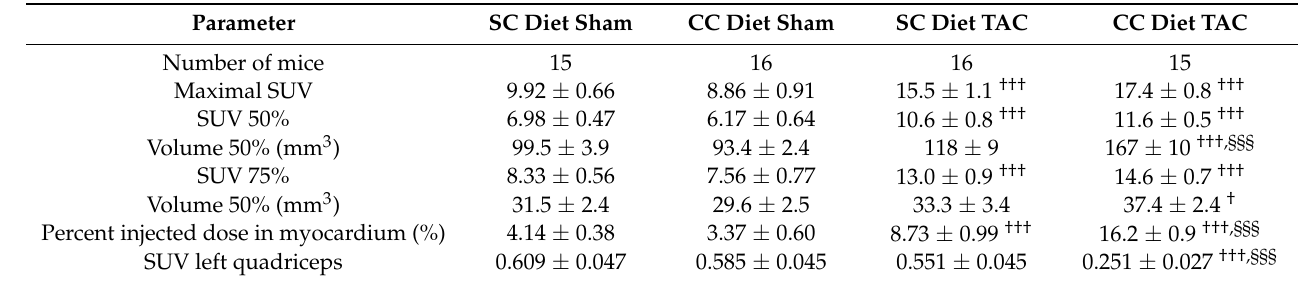
Table 5. Quantification of glucose uptake in the myocardium determined by micro-PET eight weeks after sham operation or after TAC in C57BL/6 mice fed the SC diet or the CC